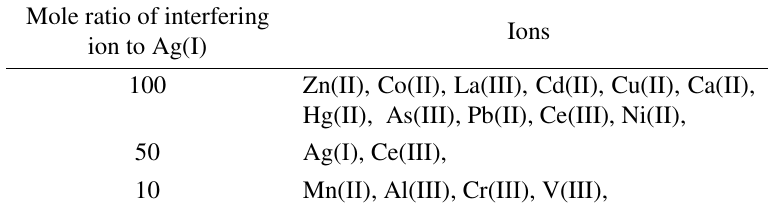
Table 1 . Tolerance ratio of the foreign ions on the determination of 5 × 10 -5 M of Fe(III) in 25 mL of the aqueous phase.